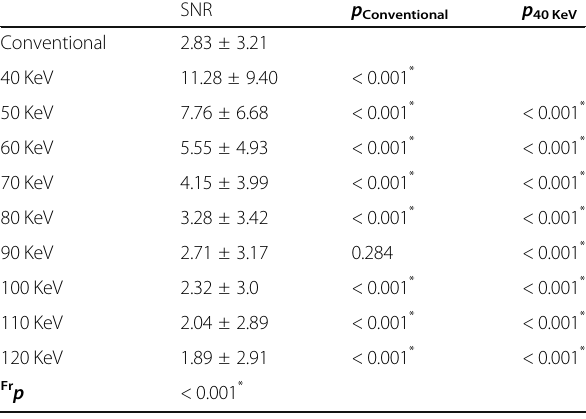
Table 2 Quantitative analysis of image sets (conventional images and VME images 40 – 120 KeV) according to SNR